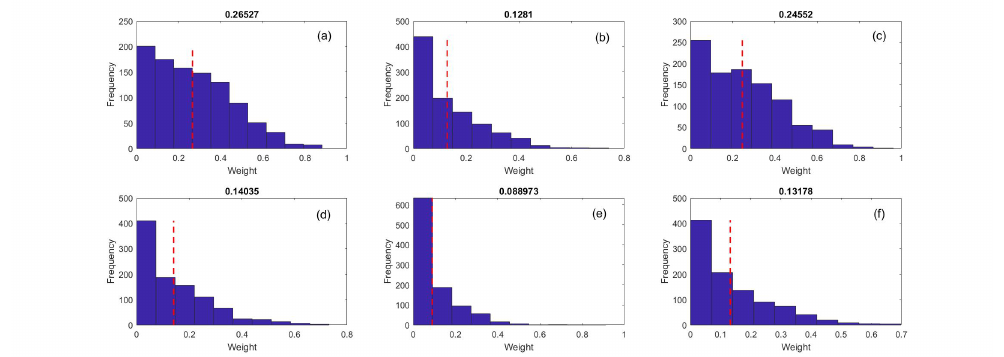
Figure 11. Histogram of investment weight per stock: ( a ) Stock 1; ( b ) Stock 2; ( c ) Stock 3; ( d ) Stock 4; ( e ) Stock 5; ( f ) Stock